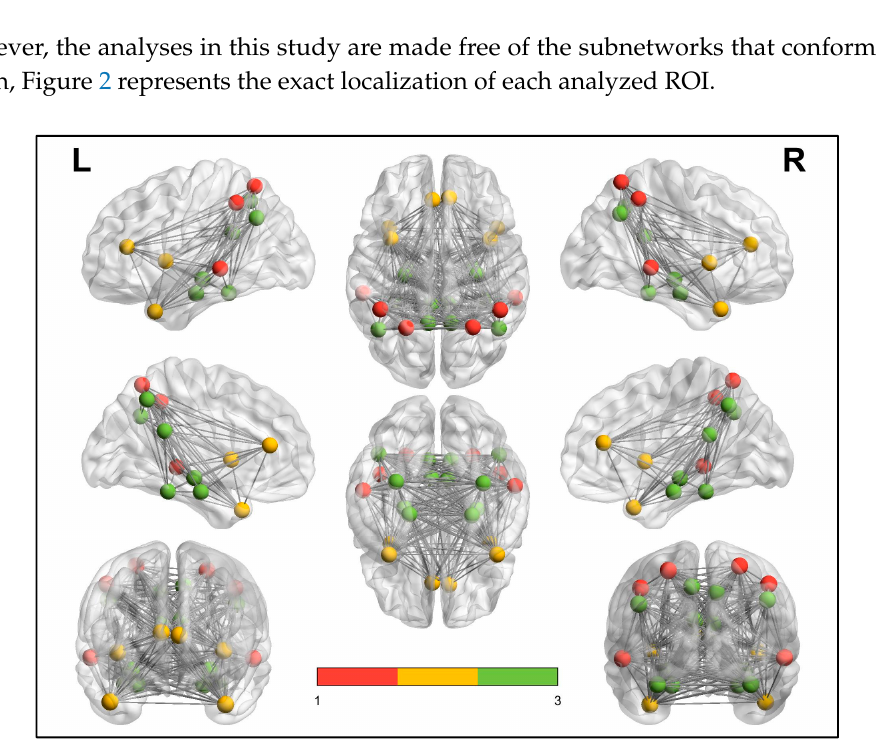
Table 1. Relationship of regions of interest (ROIs) for the construction of the Default Mode Network (DMN) and subnetworks considered according to the AAL90 atlas.